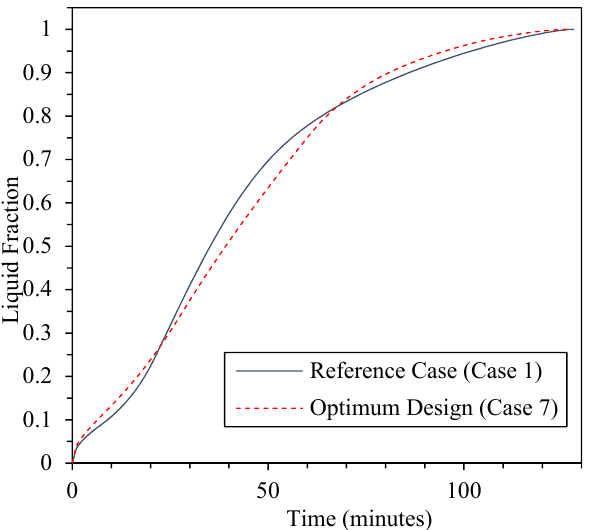
Figure 13. Melting evolution comparison between the reference case and the new design.